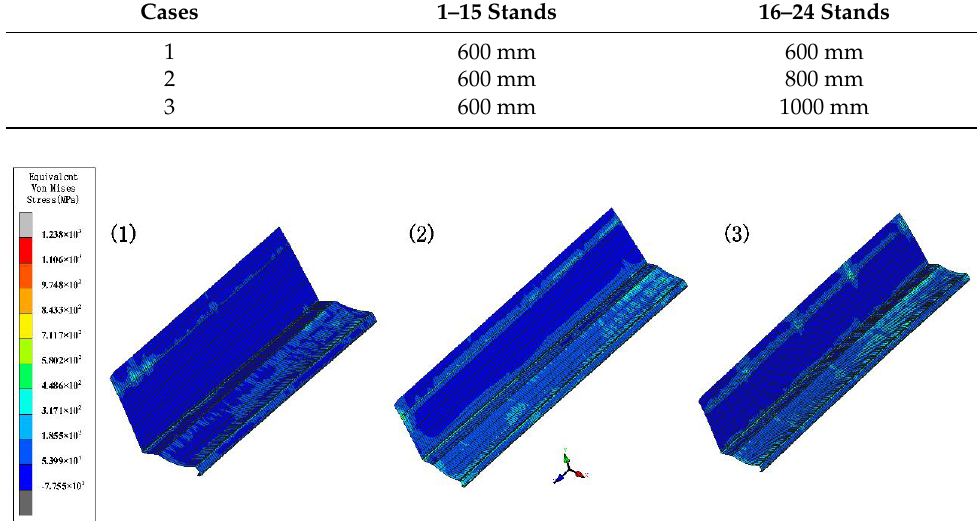
Figure 10. The variation in the equivalent von Mises stress distribution of strip under three cases.